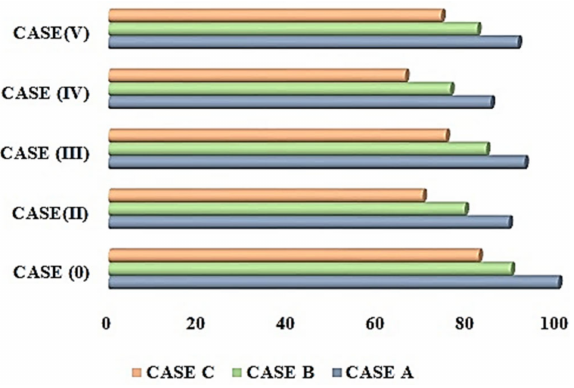
Figure 8. Comparison of operating cost of MG based on EV Selection